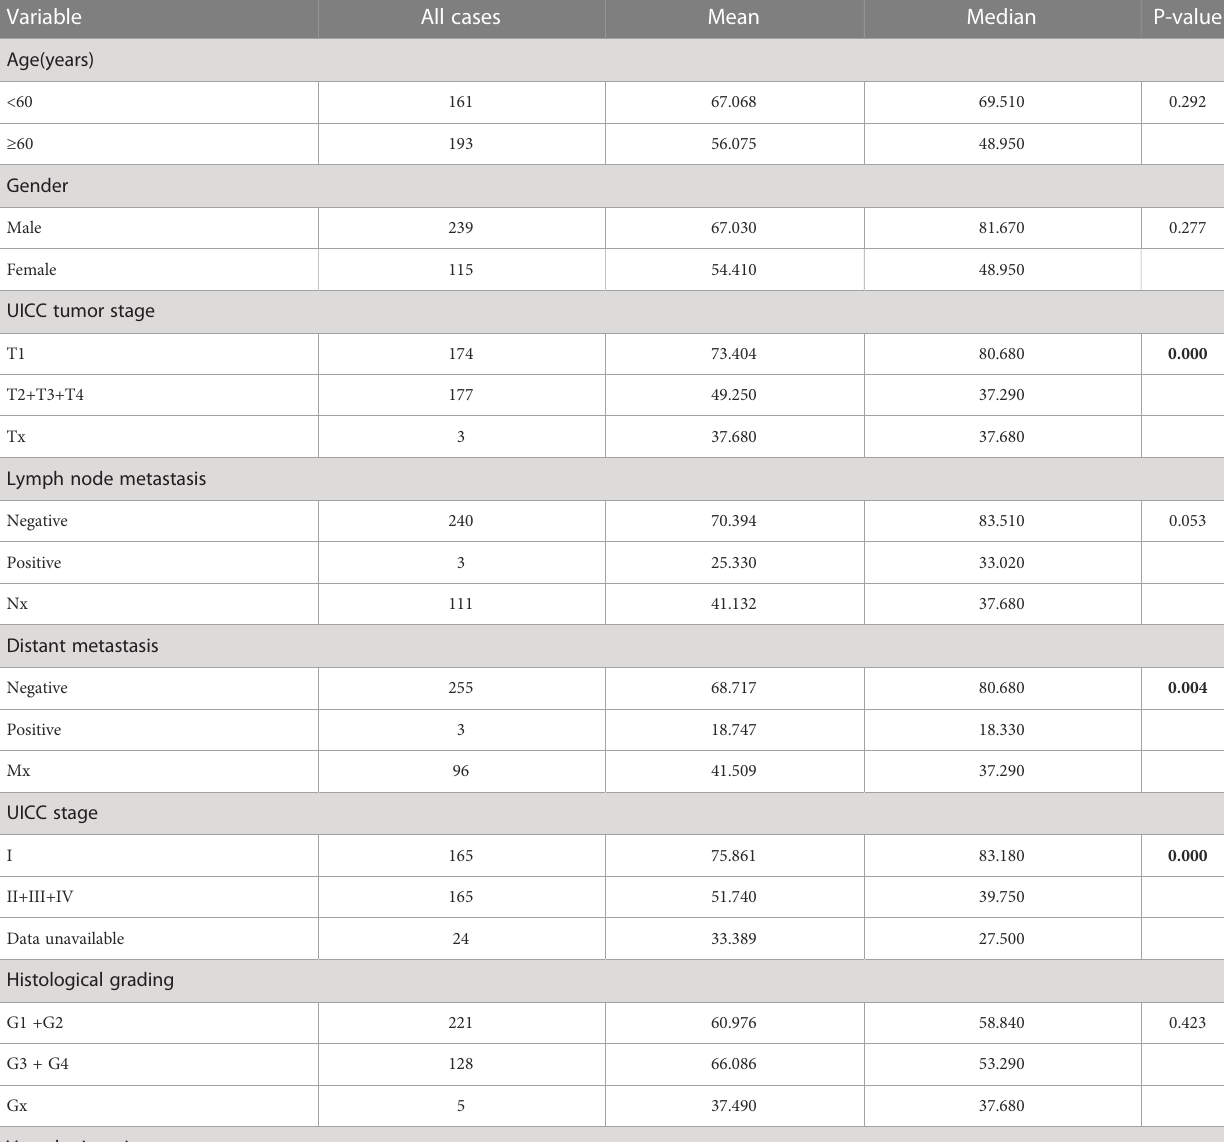
TABLE 2 Univariate analysis indicating associations between overall survival and various risk